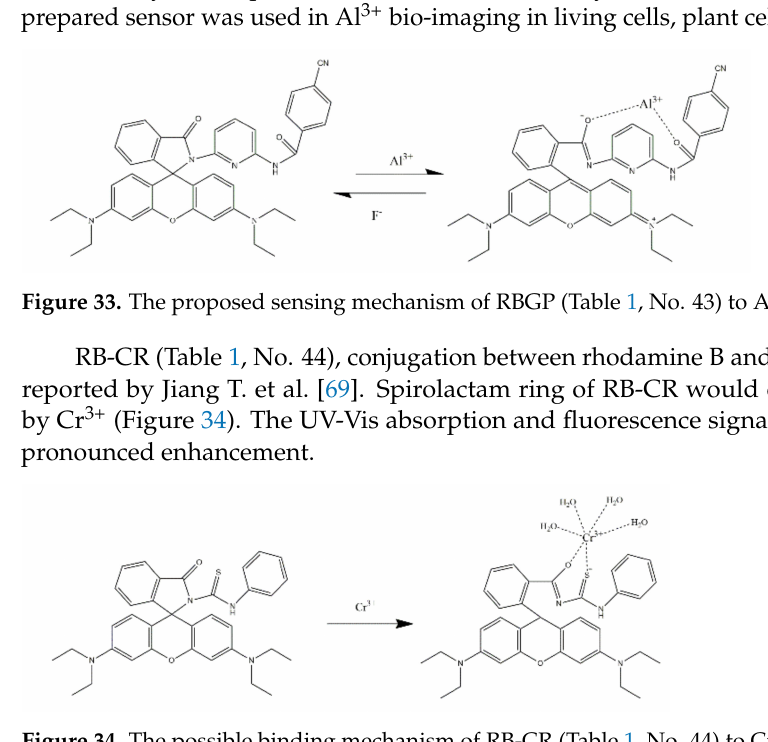
Figure 32. The proposed sensing mechanism of PBCMERI-23 (Table 1, No. 42) to As 3+ [67]. Kan C., et al. reported a supramolecular fluorescent sensor (RBGP) for Al 3+ detection (Table 1, No. 43) [68]. The prepared sensor showed a fast and stable response to Al 3+ . Additionally, the response of RBGP was reversed by the addition of F − (Figure 33). The